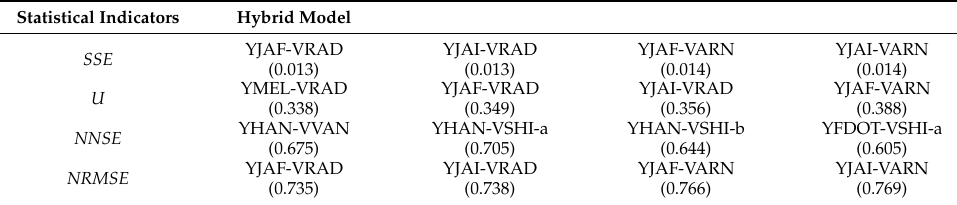
Table 5. Top hybrid models according to the statistical indicators. Statistical